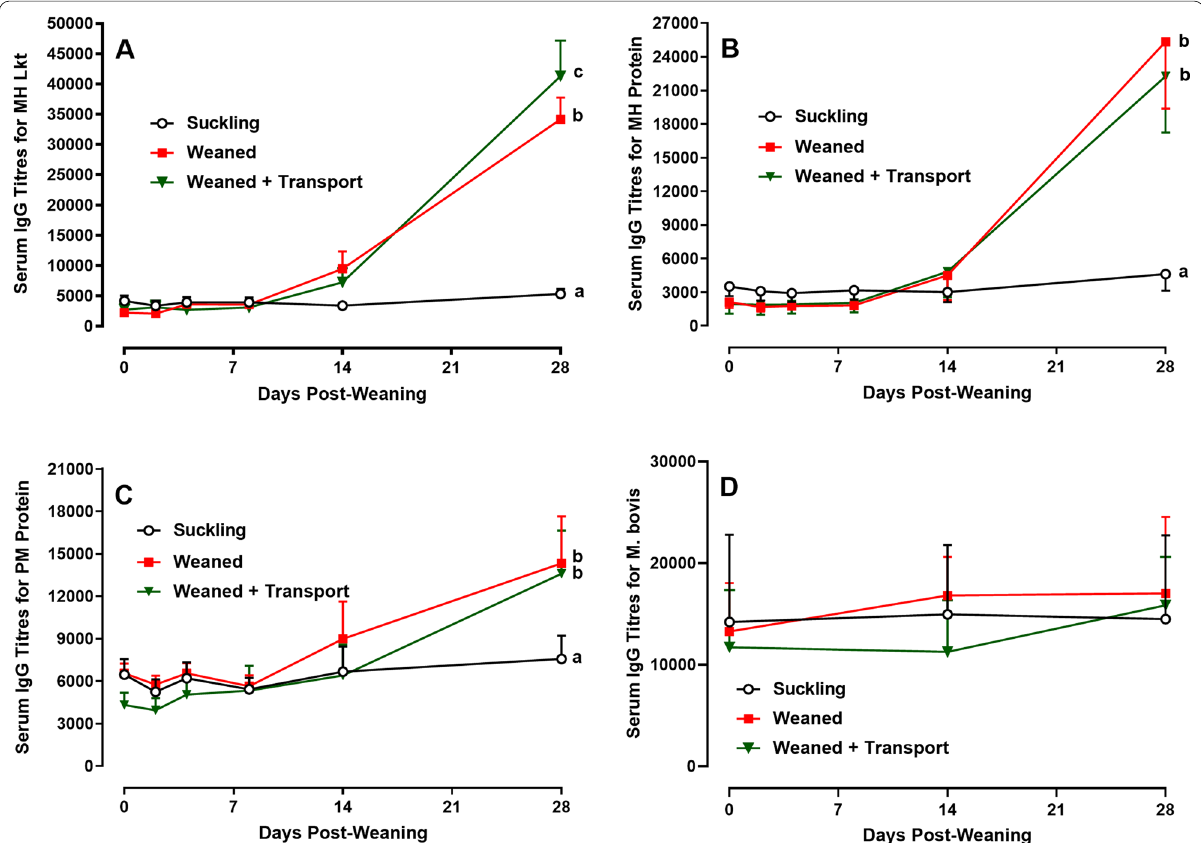
Fig. 2 Serum antibody responses to M. haemolytica and P. multocida in suckling calves and in calves following weaning and transportation stress. Antibody titres to M. haemolytica were measured using both a recombinant leukotoxin (Lkt) protein ( A ) and soluble bacterial lysate ( B ). Antibody titres to P. multocida were measured using soluble bacterial lysate ( C ). Antibody titers to recombinant My. bovis MilA‑ab ( D ). Significant differences were observed in antibody titres on Day 28 for M. haemolytica and P. multocida , when comparing among the three treatment groups (Suckling calves, Weaned calves, and Weaned Transport calves) and these differences are indicated by letters (a,b,c). Data presented are the mean and 1 +